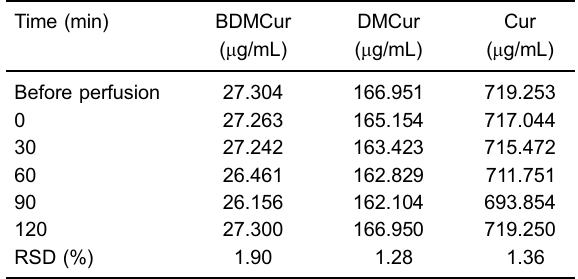
RSD: relative standard deviation.